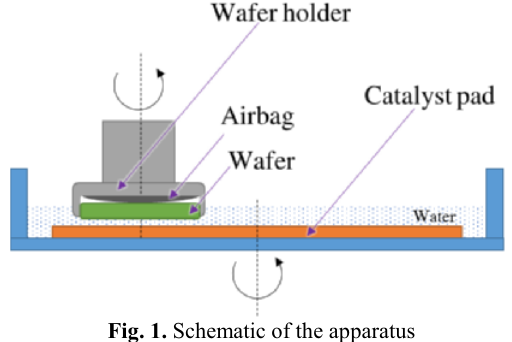
Fig. 1. Schematic of the apparatus